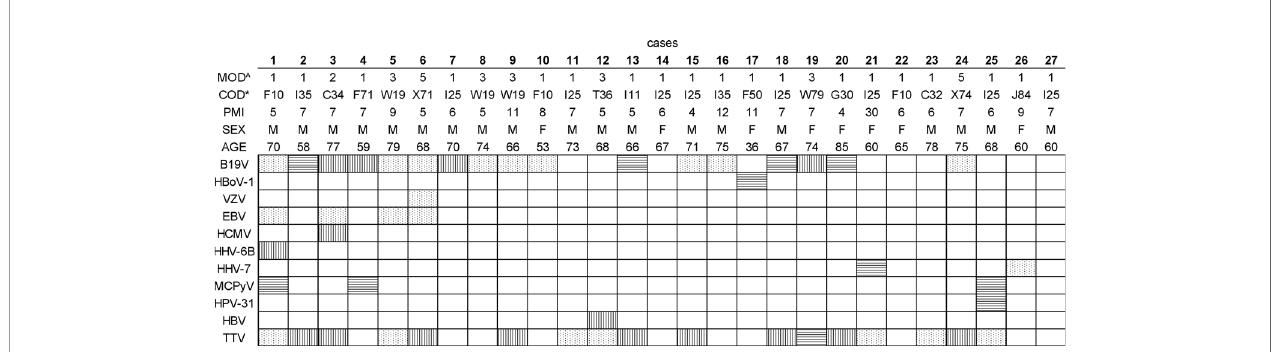
FIGURE 1 | Viral DNA prevalences in bone marrow per study subject. The viral fi ndings are presented as dots (NGS+, qPCR+), horizontal lines (NGS+, qPCR-), vertical lines (NGS-, qPCR+), and white (NGS-, qPCR-). ^The manner of death (MOD) is presented as 1=disease, 2=occupational disease, 3=injury, 5=suicide. *The cause of death (COD) is given according to the WHO ICD10 classi fi cation (https://icd.who.int/browse10/2019/en). Age is given in years. PMI, Post-mortem interval (given in days); B19V, parvovirus B19; HBoV-1, human bocavirus 1; VZV, varicella-zoster virus; EBV, Epstein-Barr virus; HCMV, cytomegalovirus; HHV-6B, human herpesvirus 6B; HHV-7, human herpesvirus 7; MCPyV, Merkel cell polyomavirus; HPV-31, human papillomavirus type 31; HBV, hepatitis B virus; TTV, torque teno